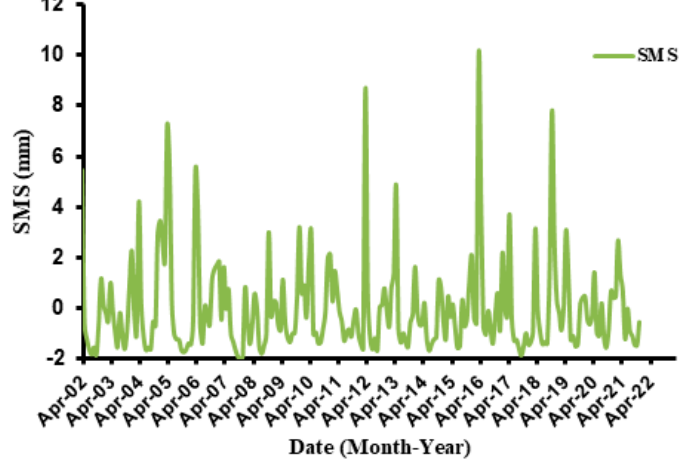
Figure 9. Monthly ∆ SMS time series for the study area. Figure 9. Monthly Δ SMS time series for the study area. Figure 9. Monthly Δ SMS time series for the study area.